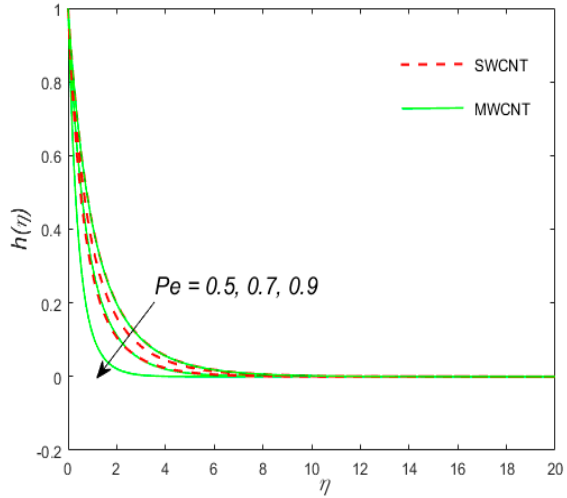
Figure 18. The variation of the local density of motile microorganisms h ( η ) for the case of SWCNT and MWCNT versus the similarity variable for the distinct values of the bio-convection Peclet number Pe .